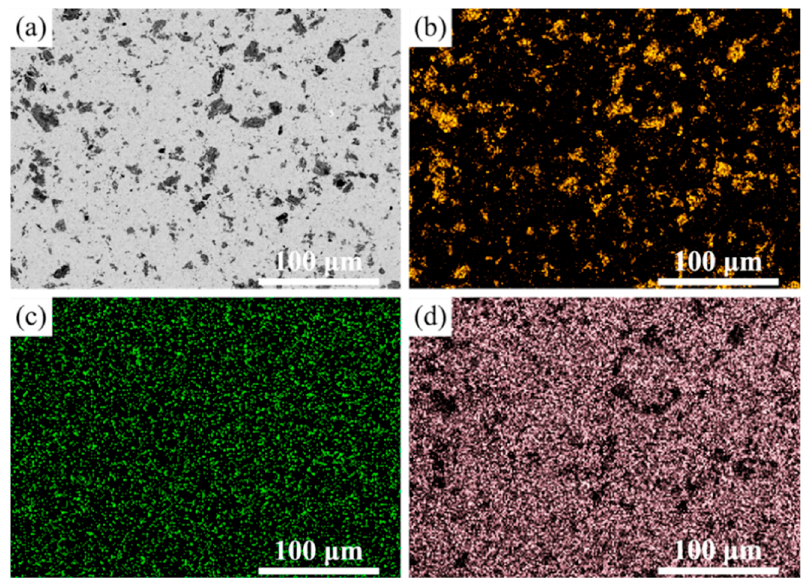
Figure 2. ( a ) Scanning electron microscope (SEM) image of Cu composite with 10 vol.% V 2 C and element distribution in the composite: ( b ) V element, ( c ) Sn element, and ( d ) Cu element.